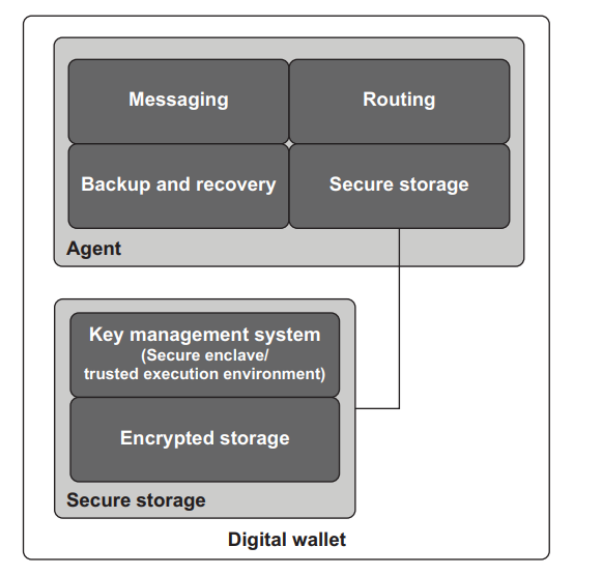
Fig. 4. Conceptual architecture of a typical SSI digital wallet and agent. 58